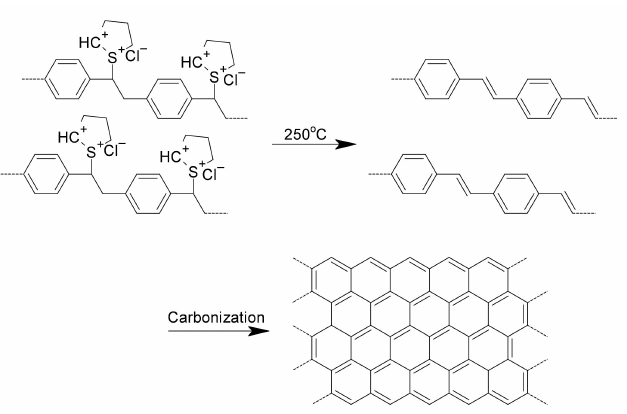
Figure 6. Chemical structure of sp 2 carbon (PPV) produced after heat treatment of